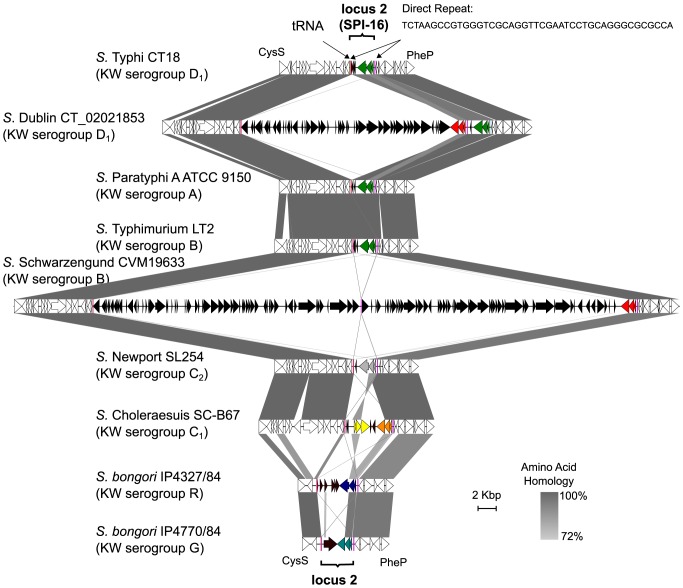
Heterogeneity of Gtr families localized within locus 2 ofSalmonella serovars.Represented is an alignment and sequence comparison of the cysS to pheP genomic region encompassing locus 2 (SPI-16, Figure 3) from nine gtr positive Salmonella serovars. The phage-associated locus 2 is defined by a pair of direct repeats (pink) and a 5′ Arg-tRNA [25]. Black coding sequences refer to those located within locus 2 boundaries, while white coding sequences are located outside locus 2. The gtr operon located within locus 2 is colored on the basis of GtrC family clustering (Figure 1). A different colored GtrC family likely reflects a functionally different gtr operon. S. Schwarzengrund contains a gtr positive lambda-like prophage and S. Dublin harbors a large remnant P22-like phage [11] within locus 2. Regions of genetic similarity between genome sequences are shaded in grey and were determined by BLASTn analysis using Easyfig [52].